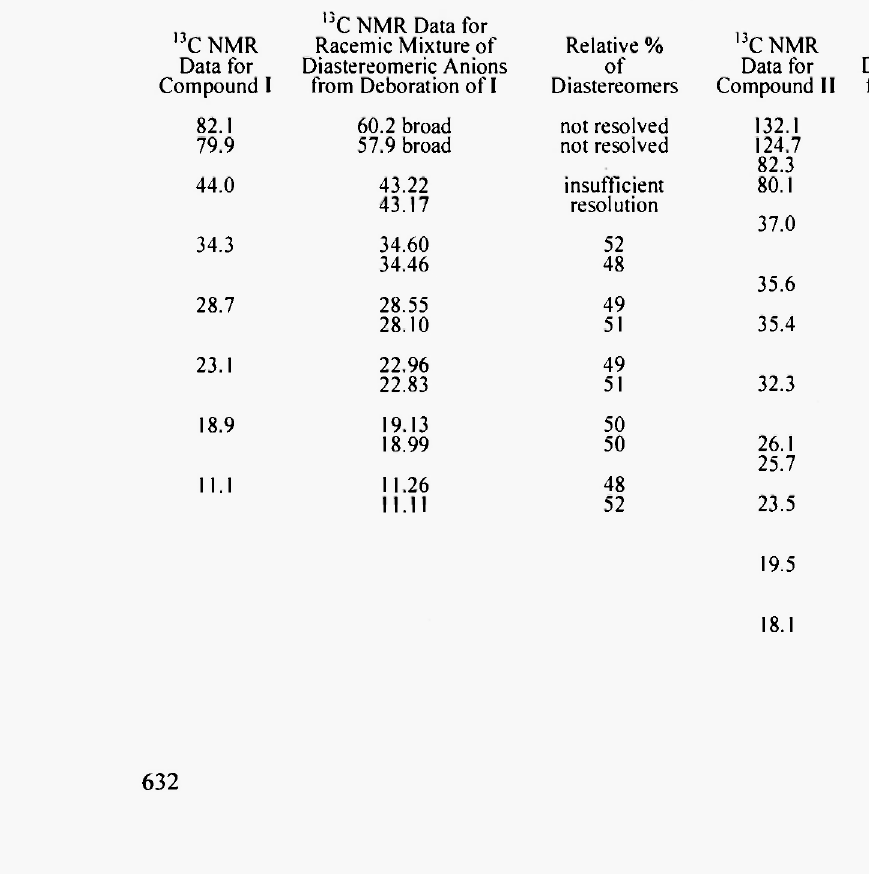
Table 1: Standardization of l3 C Integrations of the Racemic Mixtures of Anions Obtained by the Nonselective Deborations of I and II, Deborating Agent «-BuNI-b. l3 C NMR Data l3 C NMR